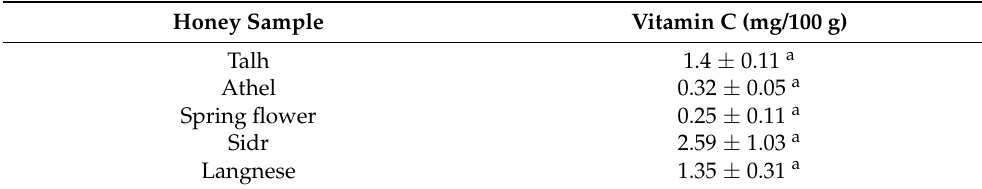
Table 3. Analysis of vitamin C in honey samples. Honey